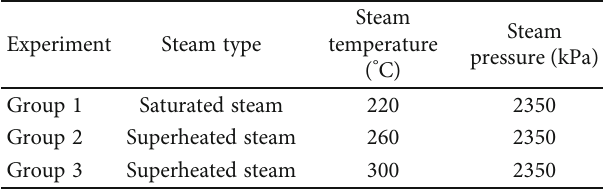
Figure 3: Oil sands in the model. Table 2: Experimental